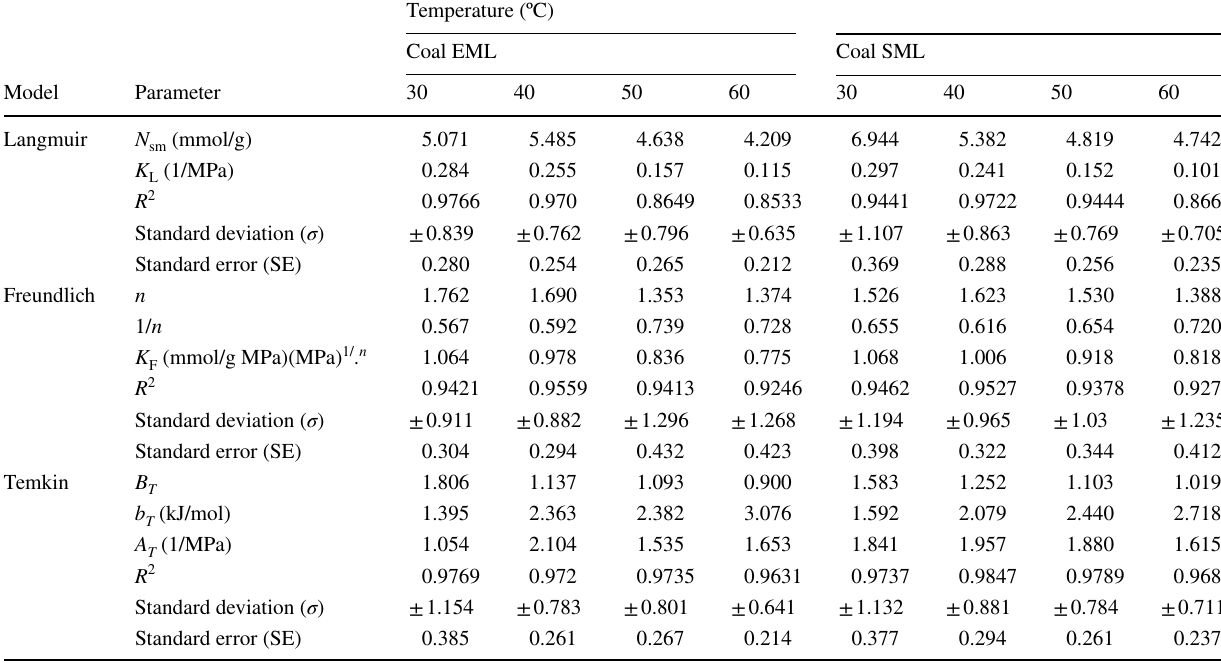
Table 1 Langmuir, Freundlich, and Temkin isotherm model parameters obtained by linear fitting for Coal EML and Coal SML at 30 ºC, 40 ºC, 50 ºC, and 60